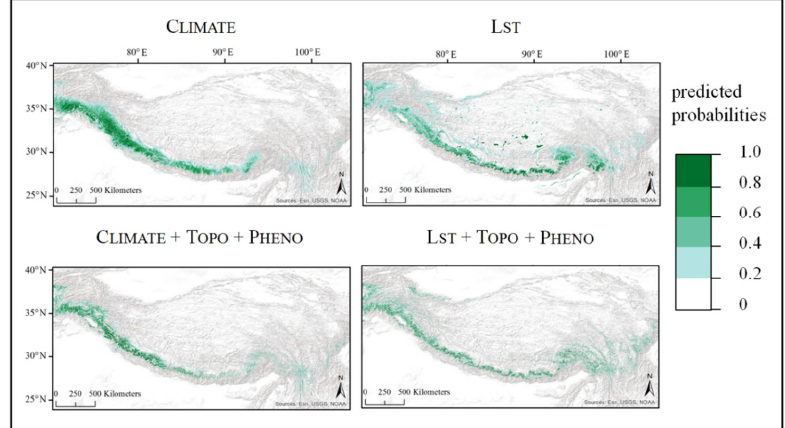
Figure 4. Continuous predictions of the models using four different predictor variable sets: Chelsa climate data (C LIMATE ); Land Surface Temperature (L ST ); and both combined with Topography (T OPO ) and Land Cover Dynamics data (P HENO ). For continuous prediction of all models, see Supplementary Material Figure S2.